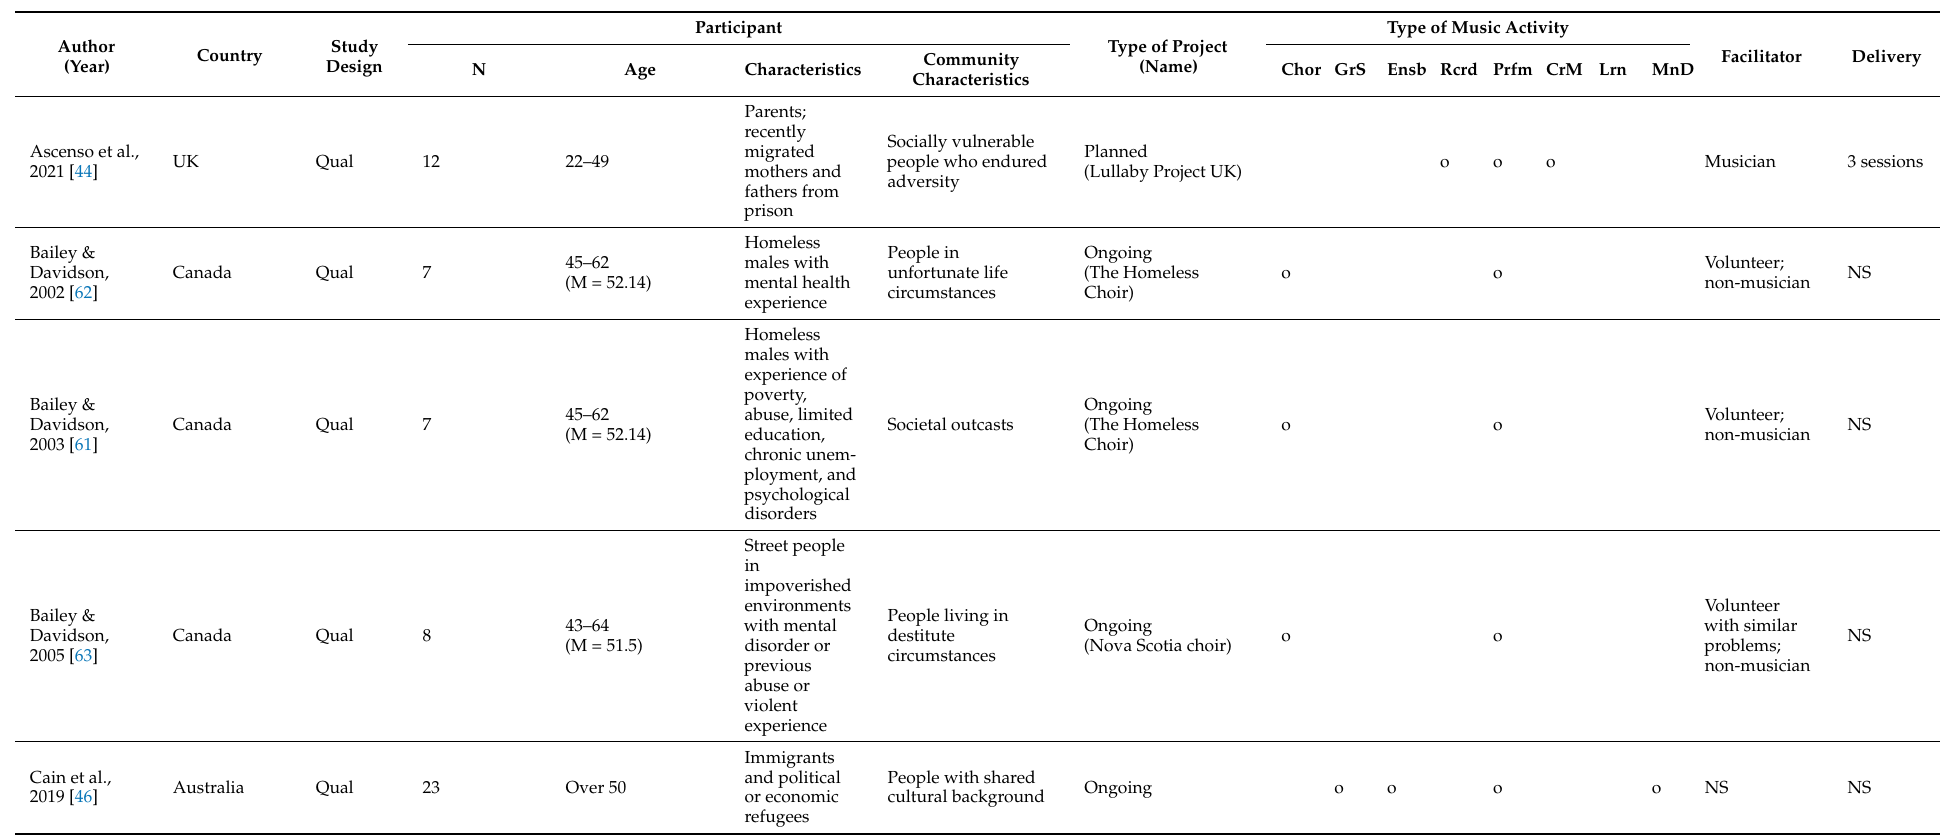
Table A1. Summary of study